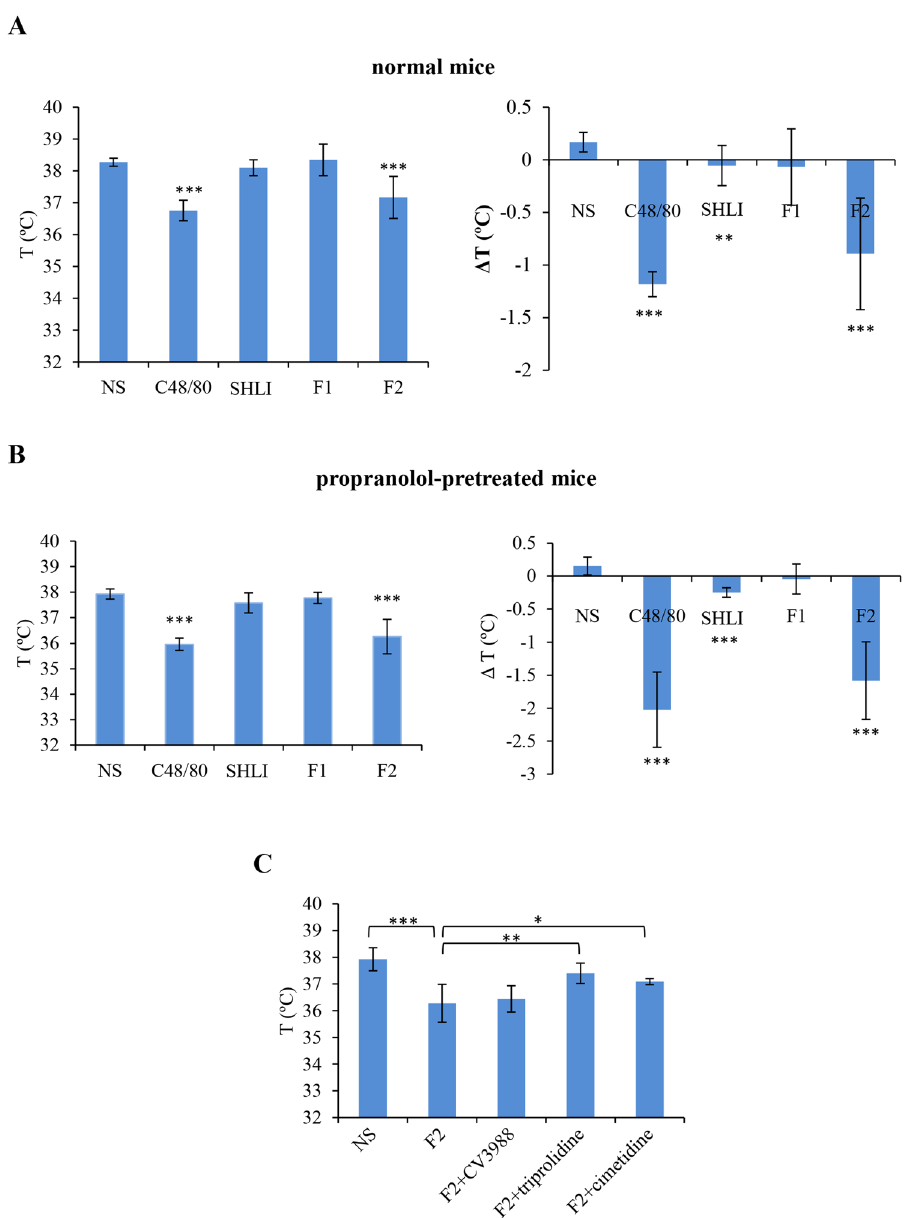
Figure 4. ( A ) F2 of SHLI induces anaphylactoid shock in normal mice (n = 6). The mice were intravenously injected with NS, C48/80 (40 μ g/mouse), SHLI (0.5 mL/mouse), F1 (4.81 mg/mouse), or F2 (16.5 mg/mouse). Thirty minutes later, the rectal temperature was measured. ** P < 0.01 and *** P < 0.001 vs . NS. ( B ) F2 of SHLI induces anaphylactoid shock in propranolol-pretreated mice (n = 6). The mice were pretreated intravenously (i.v.) with propranolol (35 μ g/mouse). Twenty minutes later, the mice were intraperitoneally injected with NS, C48/80 (40 μ g/mouse), SHLI (0.5 mL/mouse), F1 (4.81 mg/mouse), or F2 (16.5 mg/mouse). Thirty minutes later, the rectal temperature was measured. *** P < 0.001 vs . NS. ( C ) F2 of SHLI-induced shock is histamine dependent (n = 6). The mice were intraperitoneally treated with 0.2 mg/mouse of CV3988 (a PAF antagonist), triprolidine (an H1 antagonist), and cimetidine (an H2 antagonist), and then (10 min later) injected (i.v.) with propranolol (35 μ g/mouse). Twenty minutes later, the mice were challenged (i.p.) with F2 (16.5 mg/mouse). Thirty minutes later, the rectal temperature was measured. * P < 0.05, ** P < 0.01 and *** P <